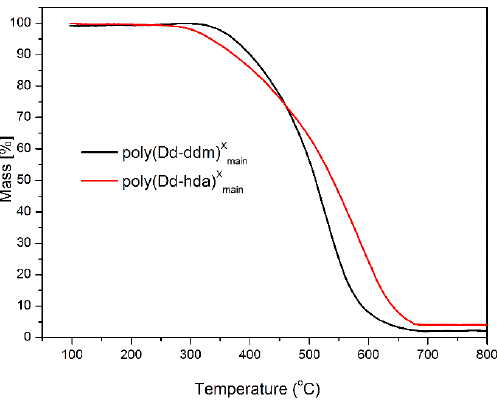
Figure 7. Thermogravimetric analysis of poly(Dd-hda) Xmain and poly(Dd-ddm) Xmain under air.